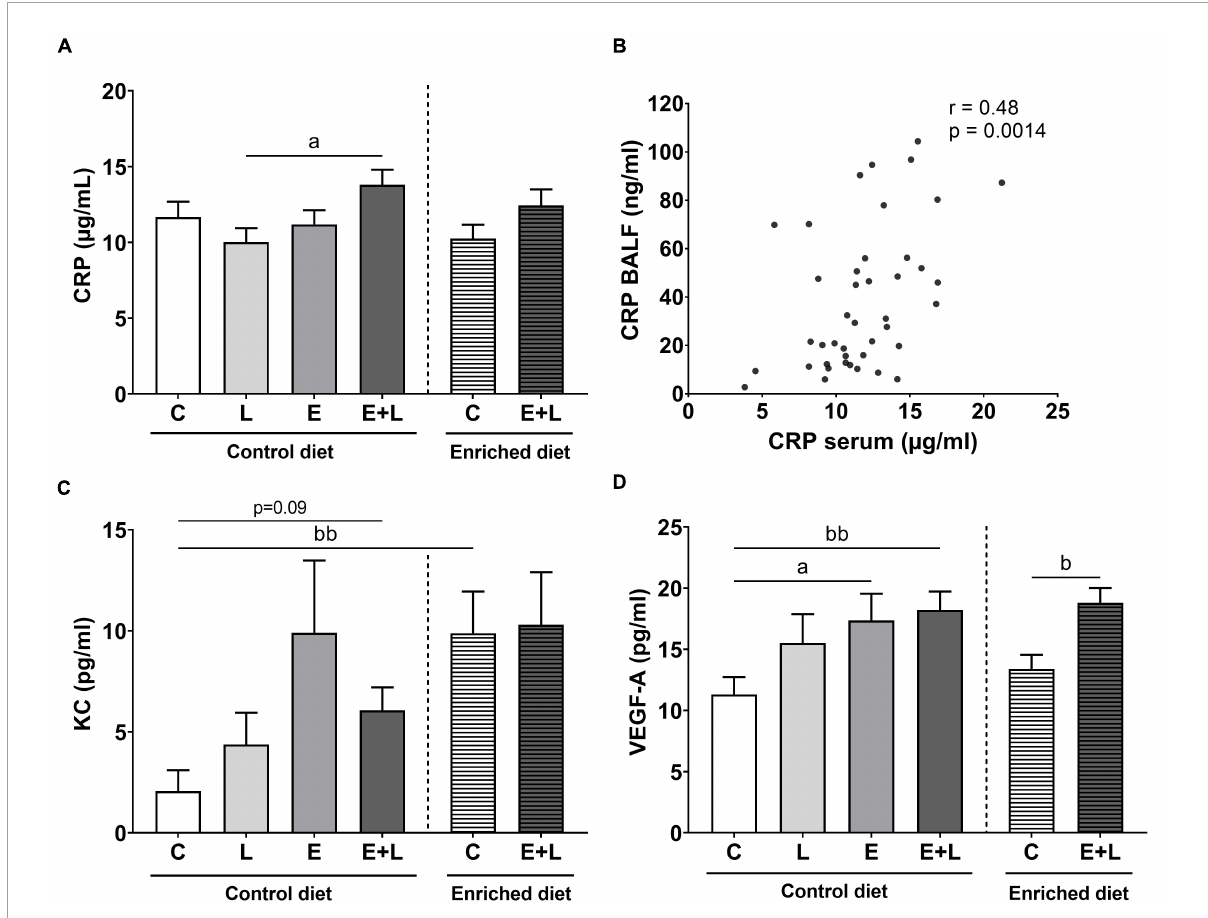
FIGURE5 Cytokine levels in serum at the end of the experiment, 10 days after the last LPS exposure. The levels of CRP (A) , KC (C) , and VEGF-A (D) have been determined. A significant correlation between CRP levels in BALF and in serum was observed (B) . Data are presented as mean ± SEM. a p < 0.05 (first analysis for elastase and/or LPS effects). b p < 0.05; bb p < 0.01 (second analysis for diet and/or E + L effects). C = control (control diet: n = 14; enriched diet: n = 13); L = LPS ( n = 13); E = elastase ( n = 16); E + L = elastase plus LPS (control diet: n = 18; enriched diet: n =